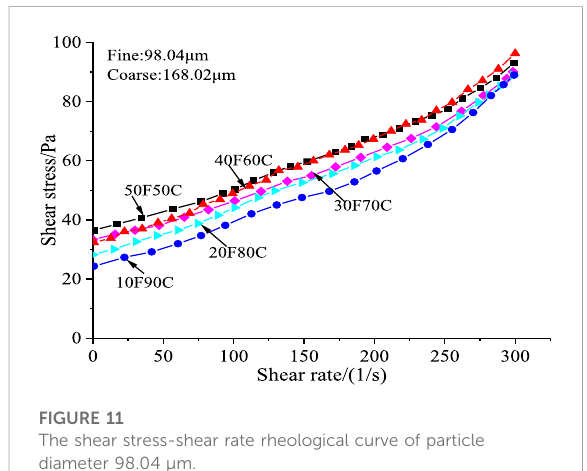
The variation curves of yield stress with different particle diameters and contents.